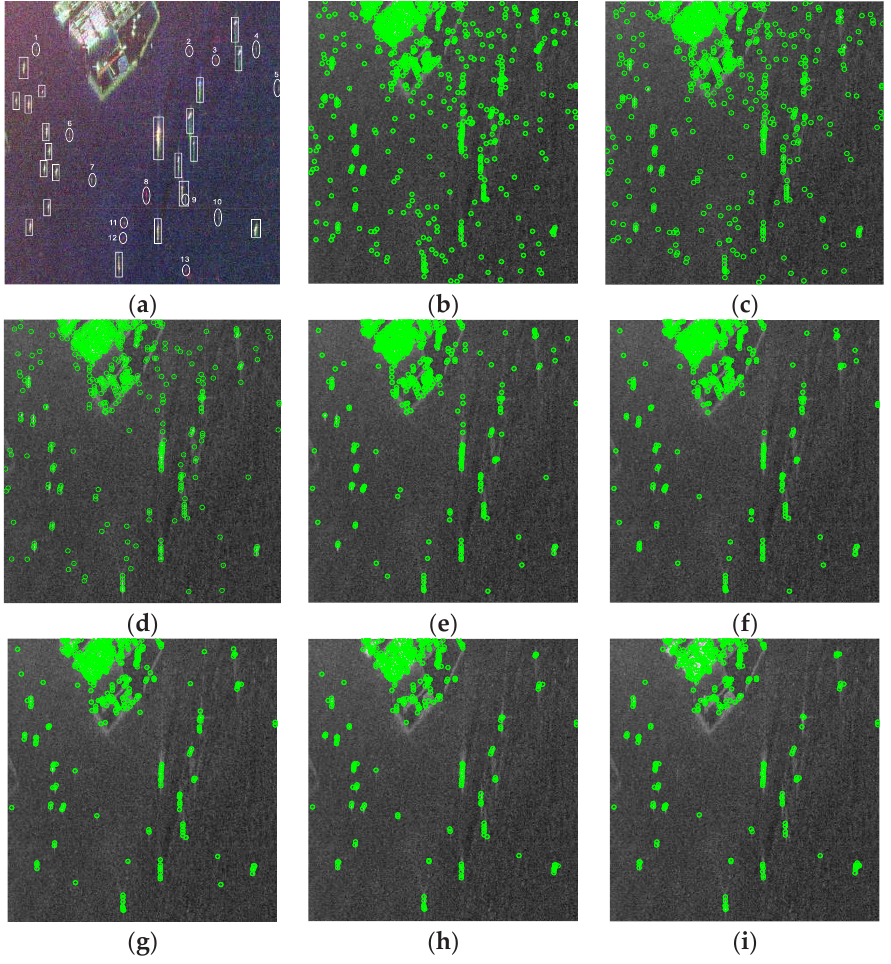
Figure 4. Pauli pseudo-color image of R2 region and keypoint detection results of R2 region with a fixed threshold T PSH and various scale parameters: ( a ) Pauli pseudo-color image; ( b ) α = 1 ; ( c ) α = 1.25; ( d ) α = 1 .58; ( e ) α = 2 ; ( f ) α = 2 .51; ( g ) α = 3 .17; ( h ) α = 4; and ( i ) α = 5 .03.